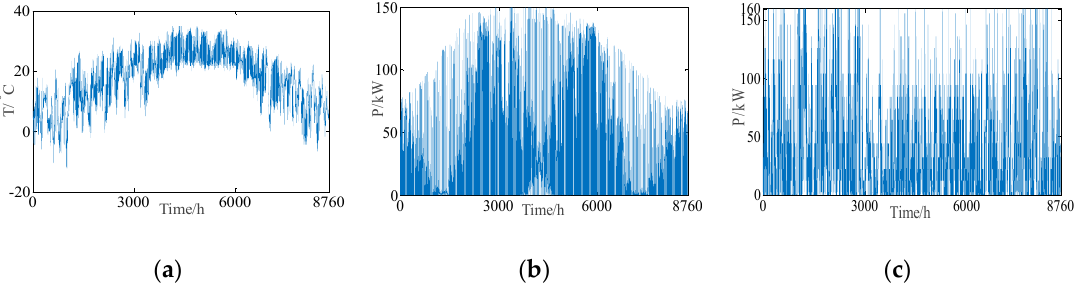
Figure 3. Annual historical temperature ( a ), Annual output power of PV ( b ), Annual output power of Wind Turbine (WT) ( c ).